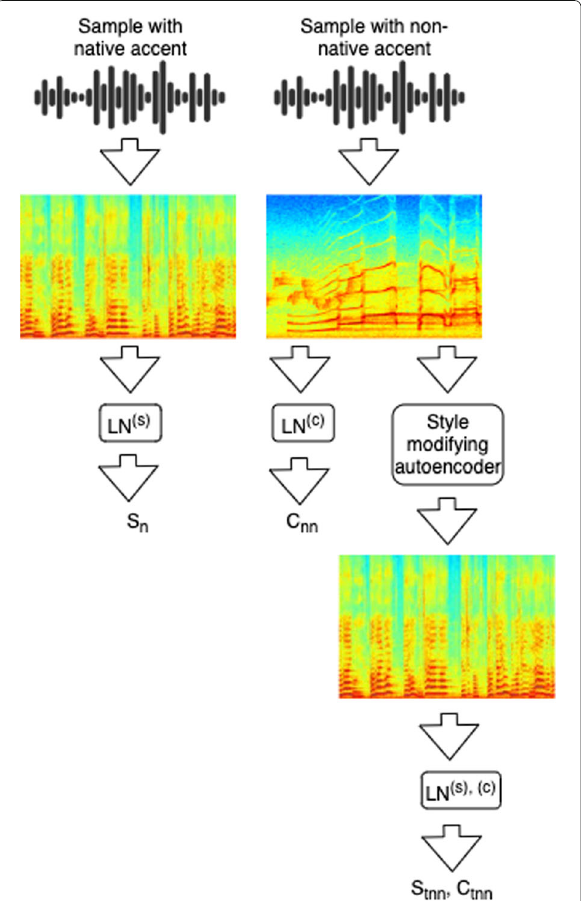
Fig. 3 Audio style transfer schema during training process. The basic diagram of style transfer-based accent